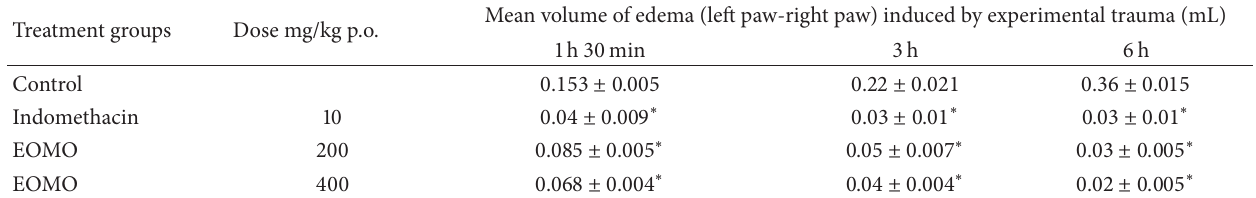
Table 3: Effect of essential oil of Melissa officinalis L. on experimental trauma-induced rat paw edema. Treatment groups